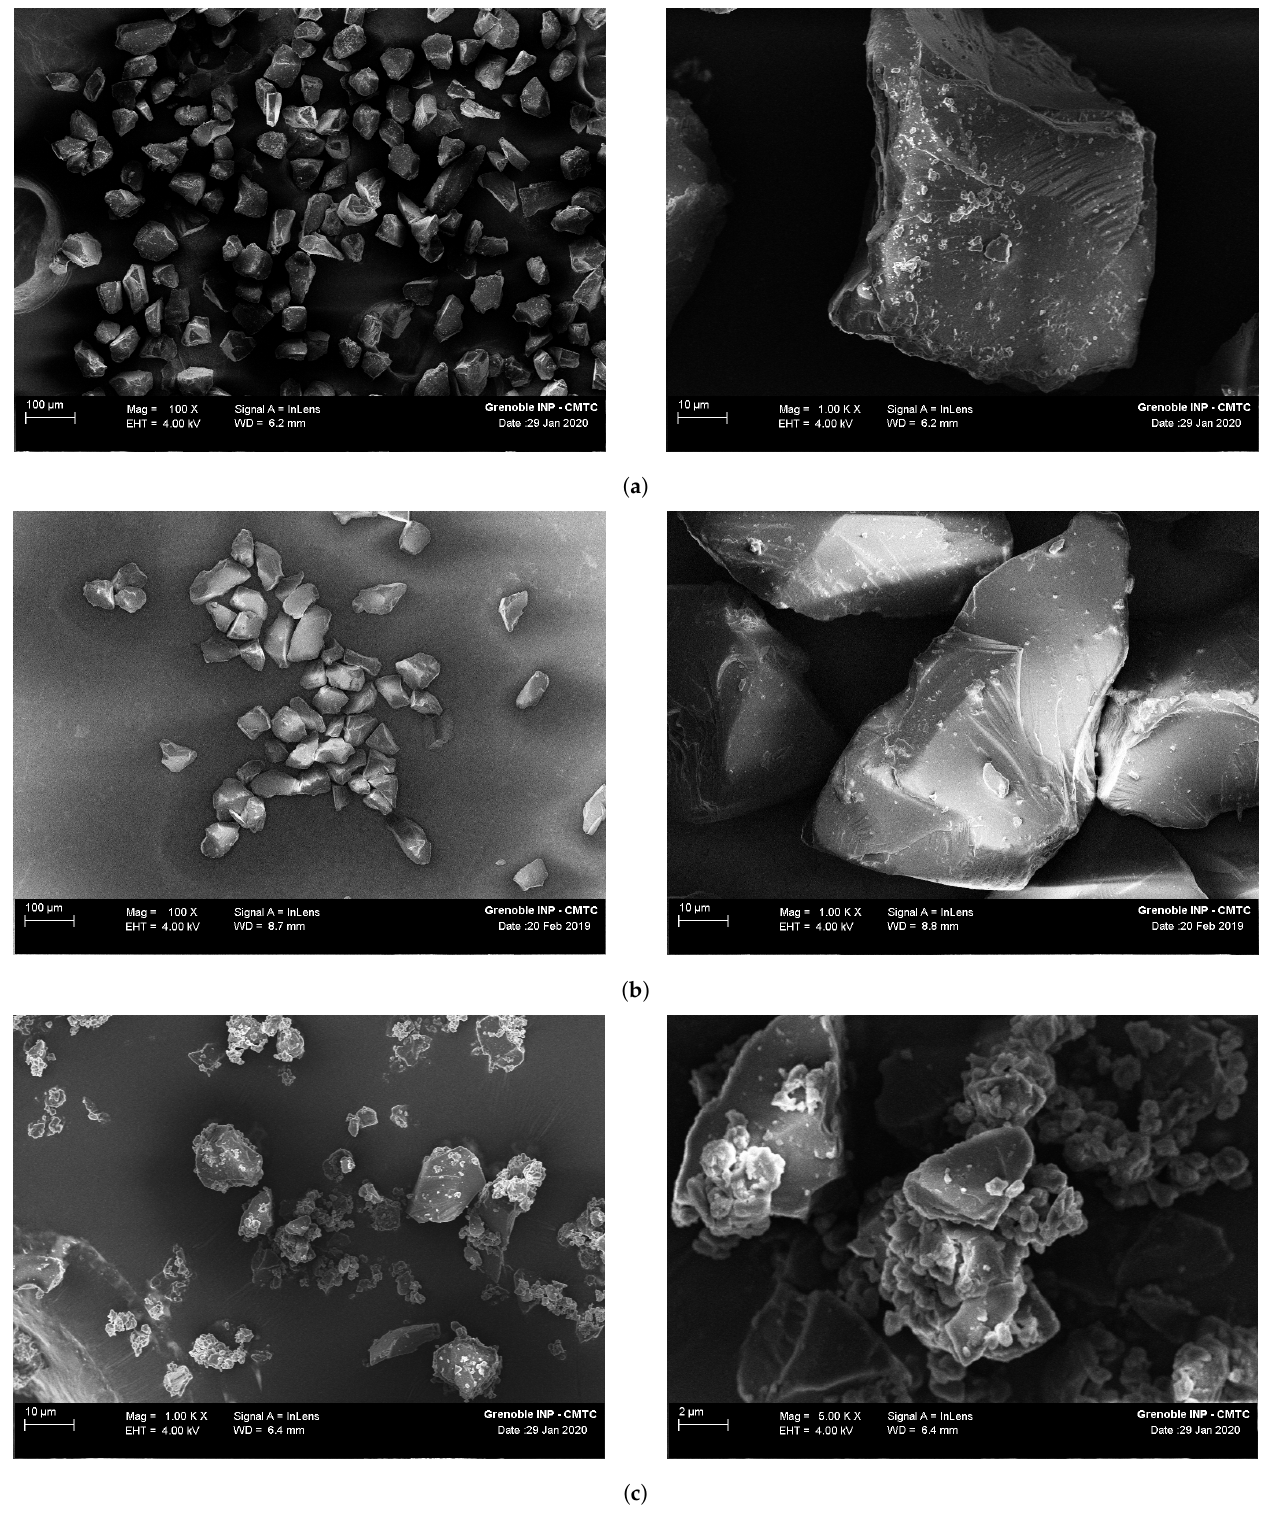
Figure 11. SEM secondary electron mode images of the ( a ) kerite 45–63 , ( b ) kerite 25–50 , and ( c ) kerite < 25 samples at two levels of